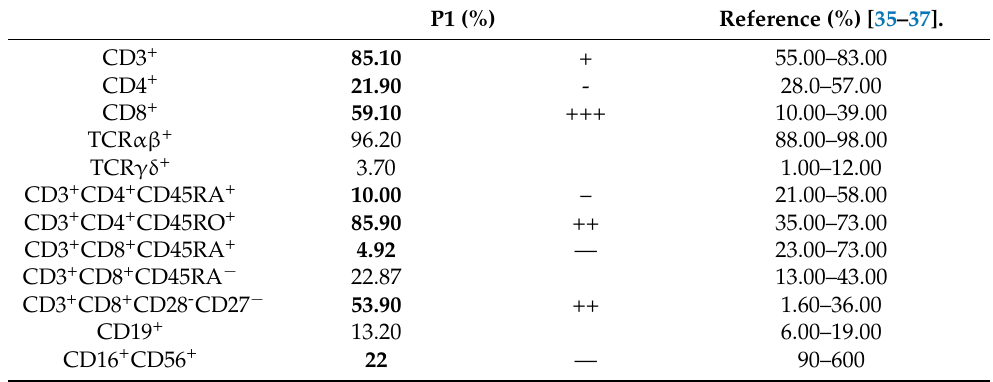
Table 4. Characteristics of reported patients carrying the IL2RG c.458T > C; p.Ile153Thr hypomorphic mutation.